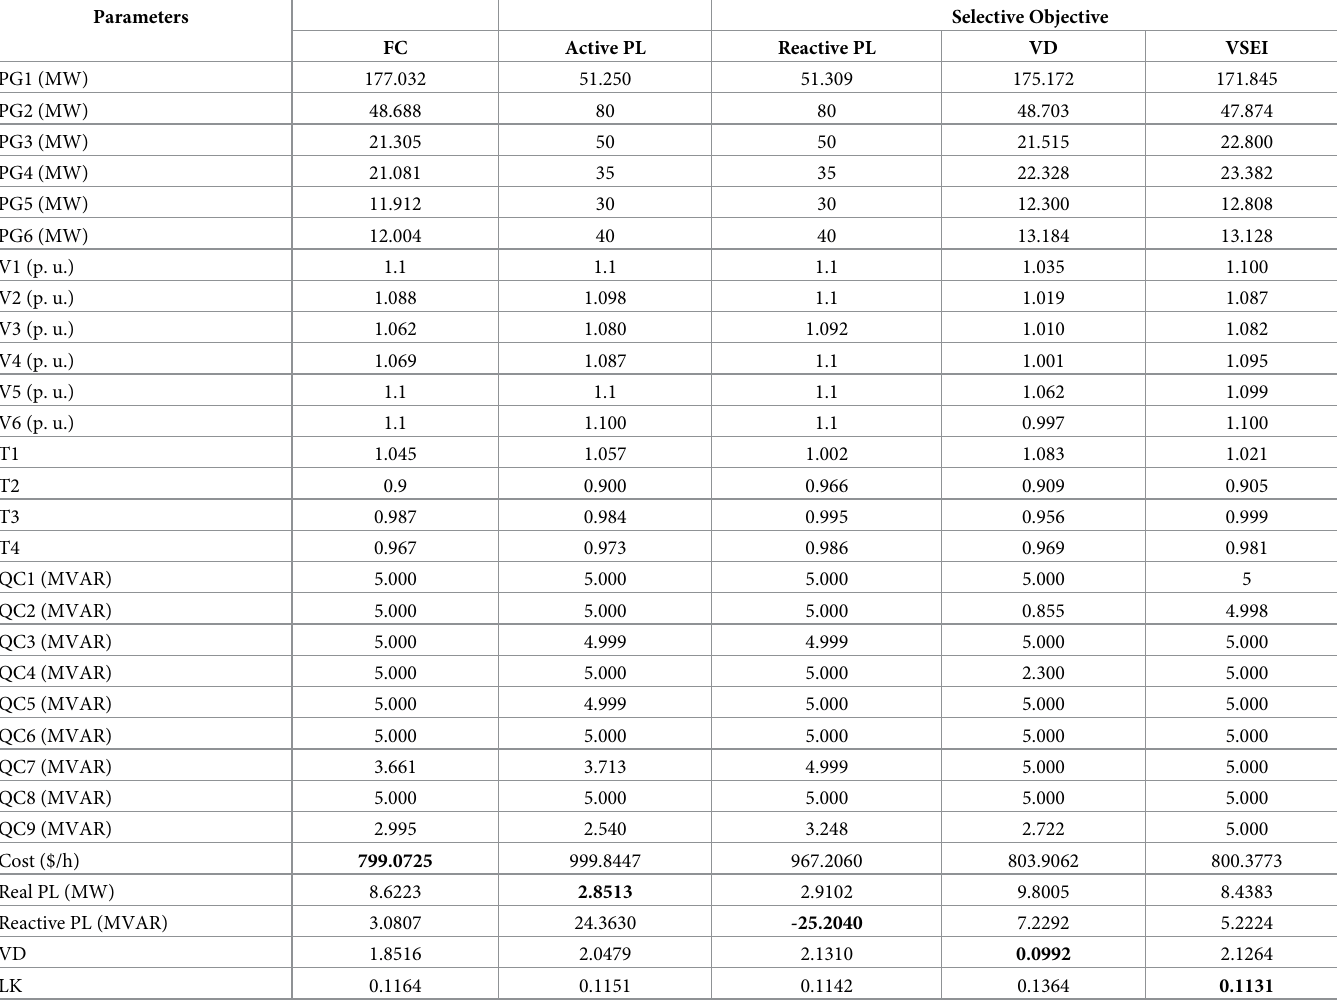
Table 1. The controlling parameters of IEEE 30-bus system for case 1 to 5 using the MPA based optimization method.